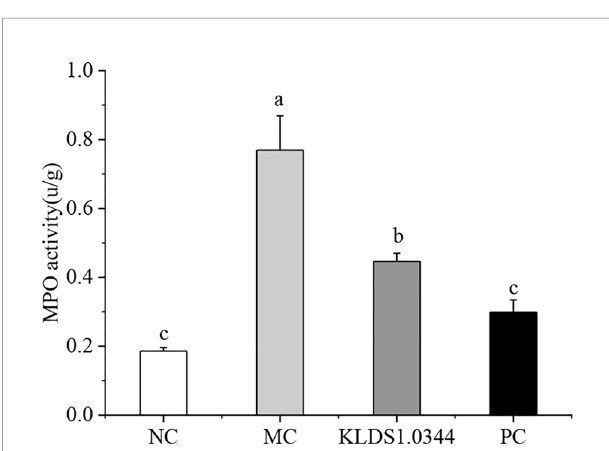
FIGURE 4 | Effect of Lactobacillus plantarum KLDS 1.0344 treatment on MPO activity in breast tissue. NC, normal control group; MC, LPS-induced mastitis group; KLDS1.0344, KLDS1.0344 pretreatment group, PC, pretreated with dexamethasone group. Values are mean ± SD. Means with no common letters differ signi fi cantly (P <